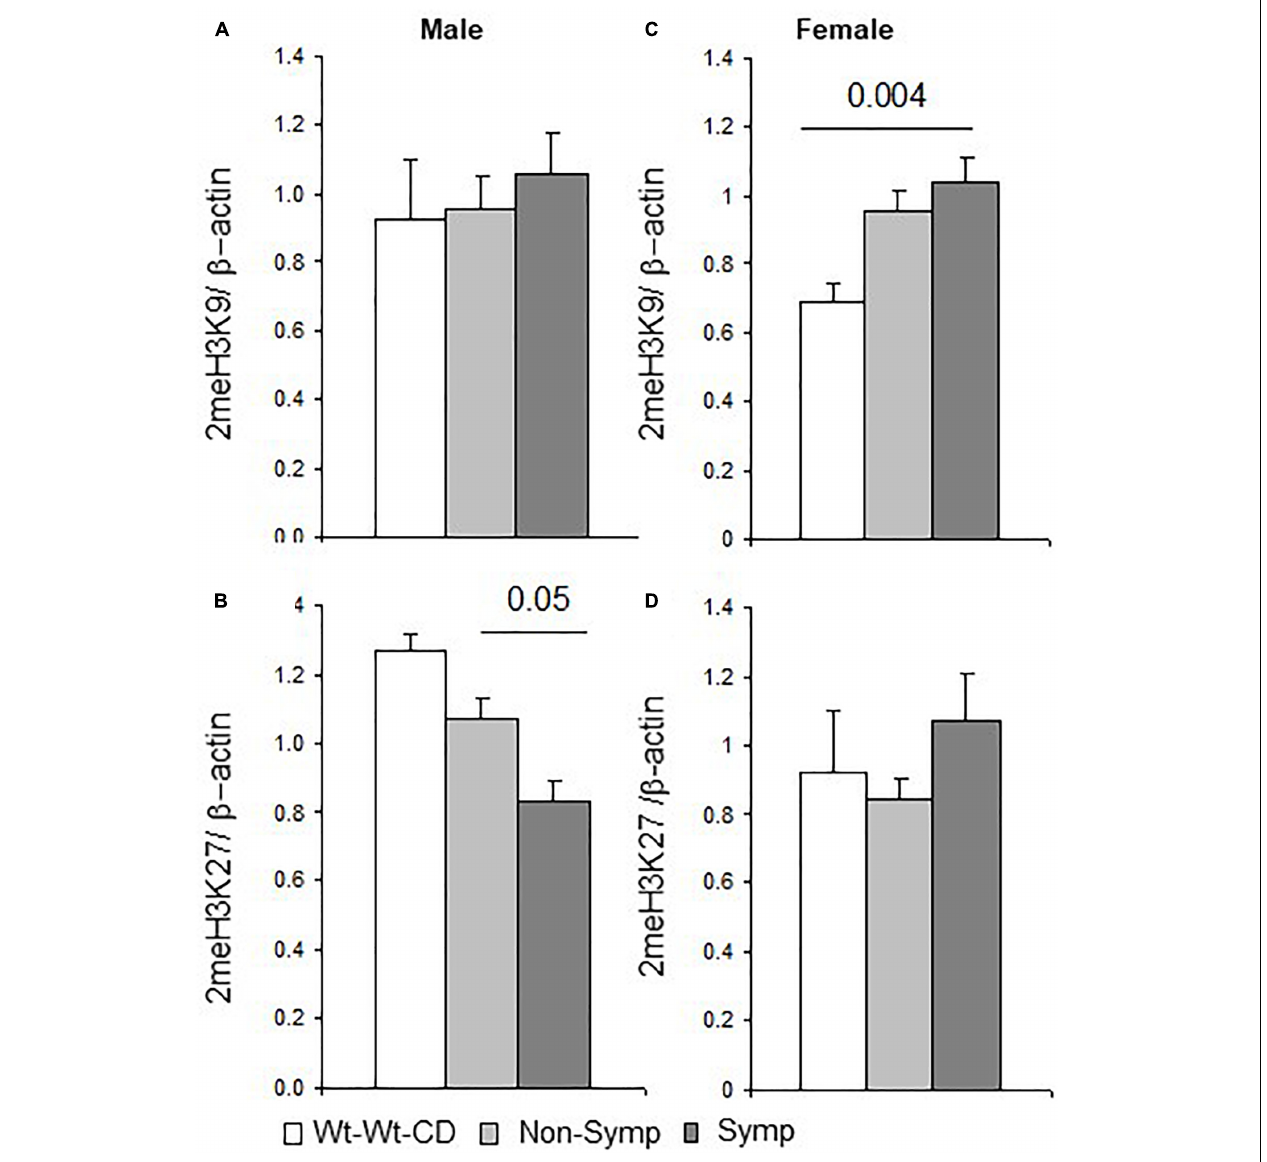
FIGURE 4 | H3 dimethylation – Effects of maternal and offspring genotypes, diet, sex and behavioral phenotype on the cerebral cortex. H3K9 and H3K27 dimethylation levels normalized to beta-actin levels and presented by behavioral categories in males (A,B) and females (C,D) . N, Male, Wt-Wt-CD, 8; Non-Symptomatic, 16; symptomatic, 8. N, Female, Wt-Wt-CD, 11; Non-Symptomatic, 25; Symptomatic, 8. Data are presented as mean ± SEM. P -value refers to the difference between groups connected by a